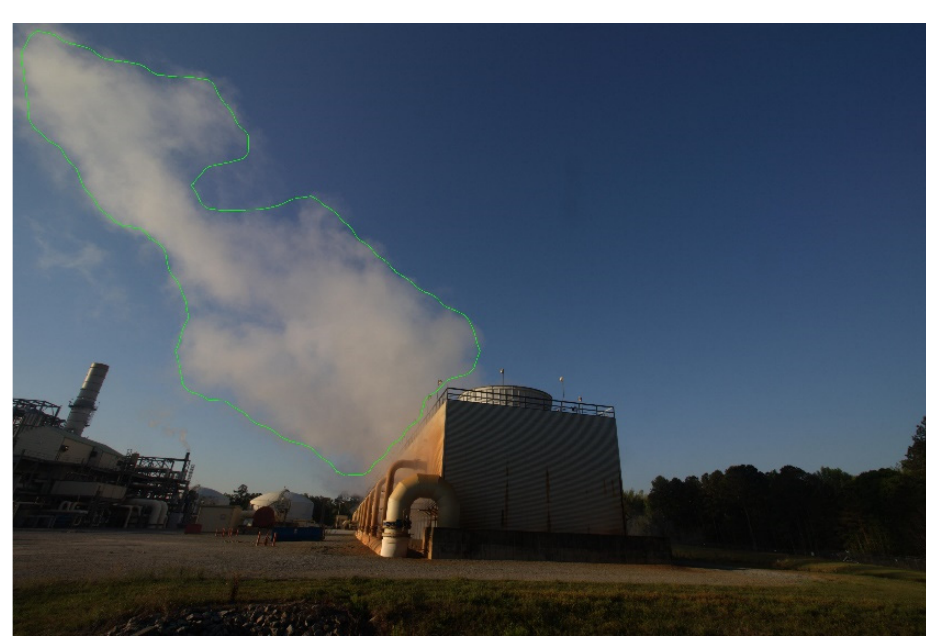
Figure 10. Example Mask R-CNN inference overlay on RGB image.